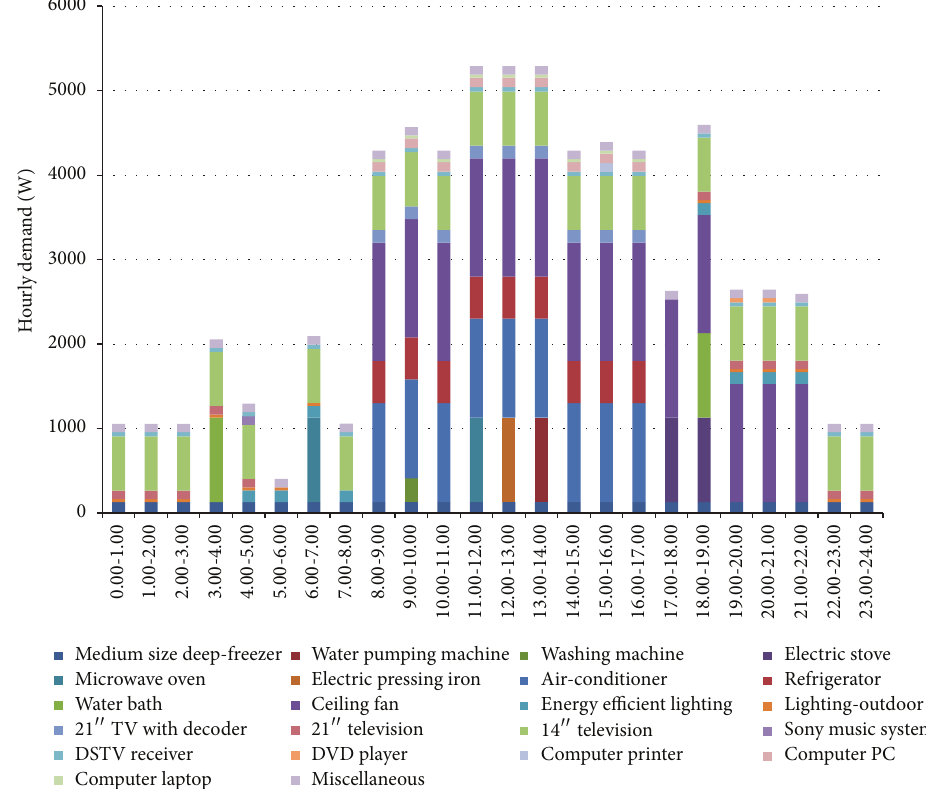
Figure 1: Hourly power demand profile of the household.